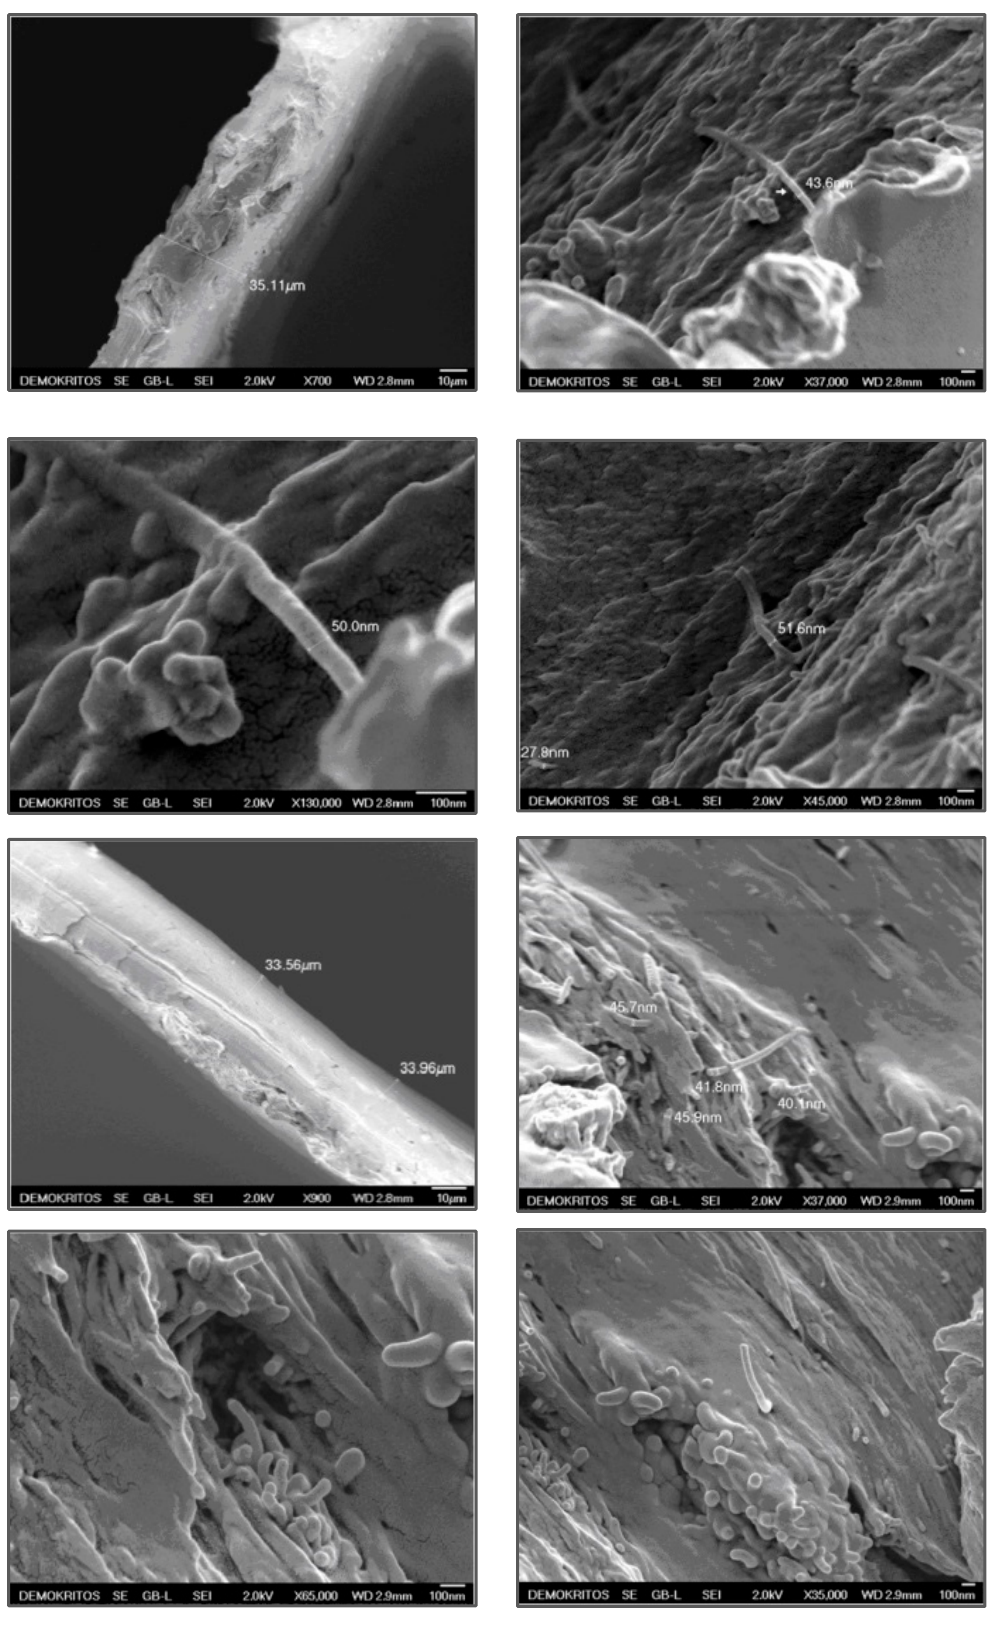
Figure 4. SEM images of PIMWNT2 (upper 2 rows) and PIMWNT5 (bottom 2 rows) mixed matrix